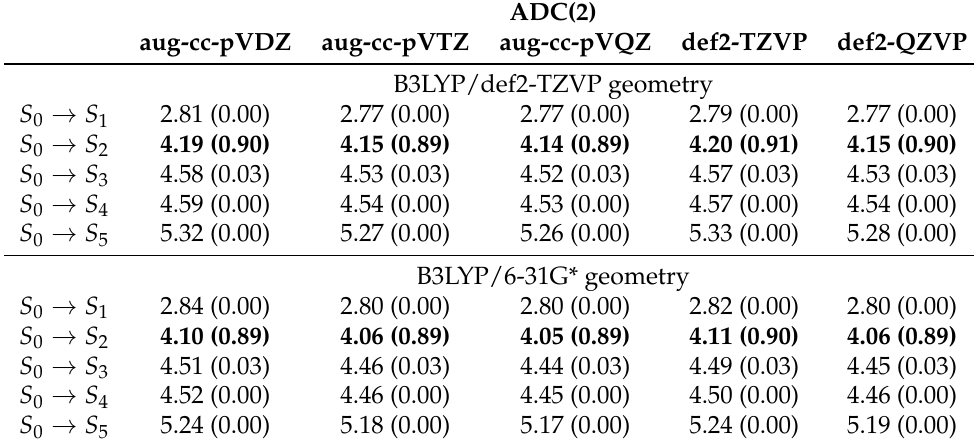
Table 2. Vertical excitation energies in eV and oscillator strengths (in parentheses) of the lowest five electronic transitions of trans azobenzene calculated with ADC(2) and five basis sets (aug-cc-pVDZ, aug-cc-pVTZ, aug-cc-pVQZ, def2-TZVP, def2-QZVP) at the B3LYP/def2-TZVP and B3LYP/6-31G* optimized geometries. The brightest transitions are shown in